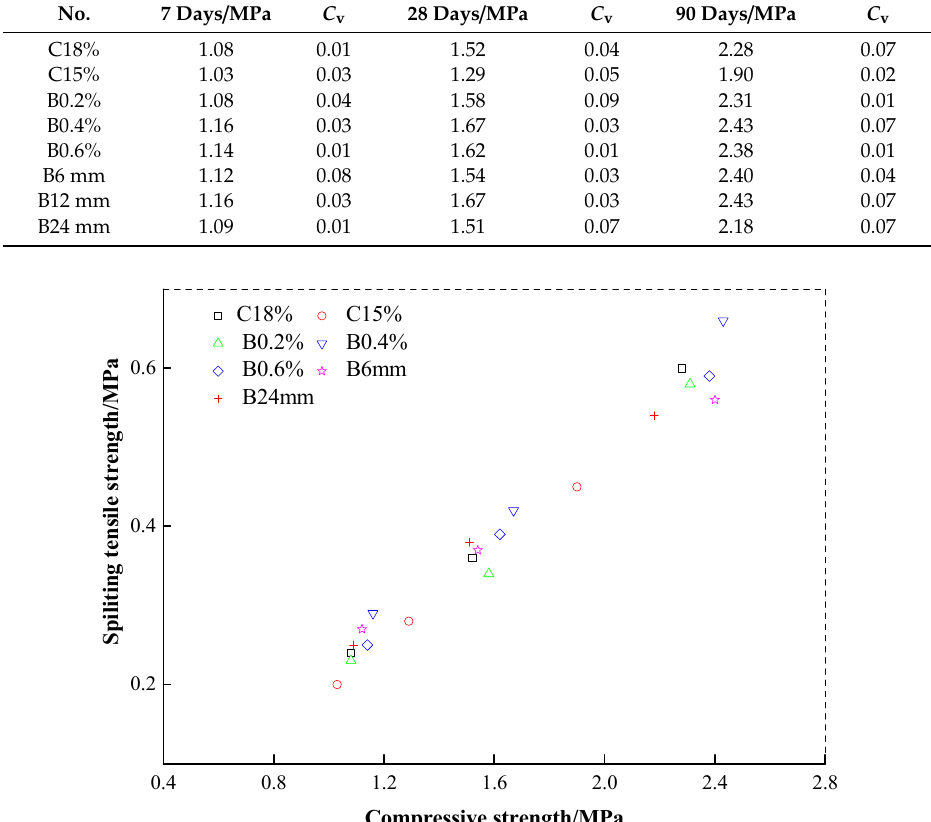
Table 8. Fitting results of the relationship between tensile strength and compressive strength.